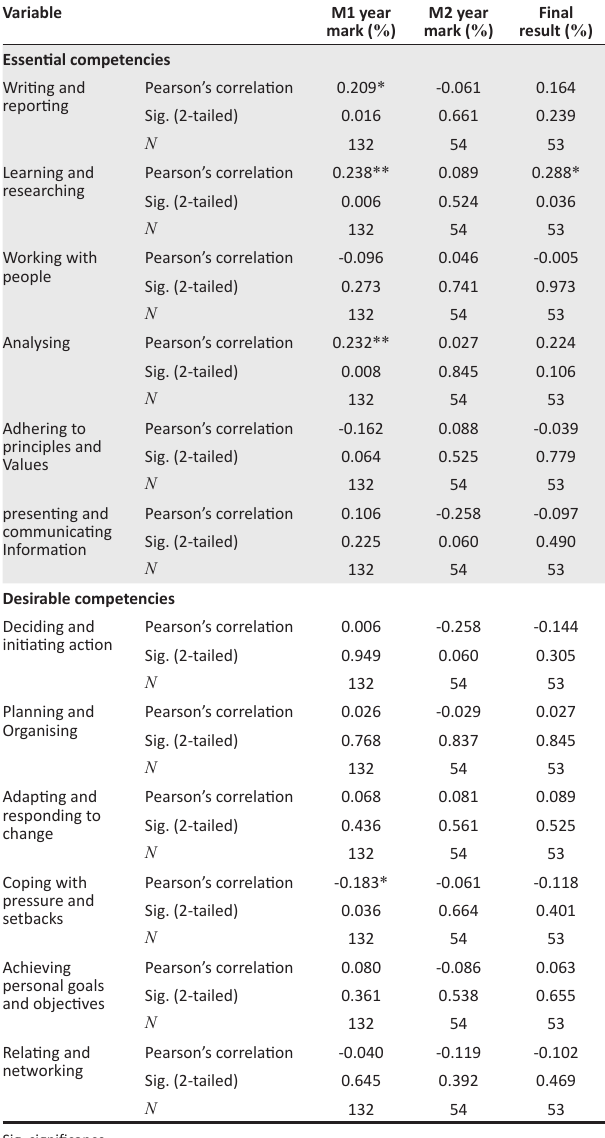
TABLE 3: Pearson correlation statistics: Essential and desirable person job match competency scores with academic success.